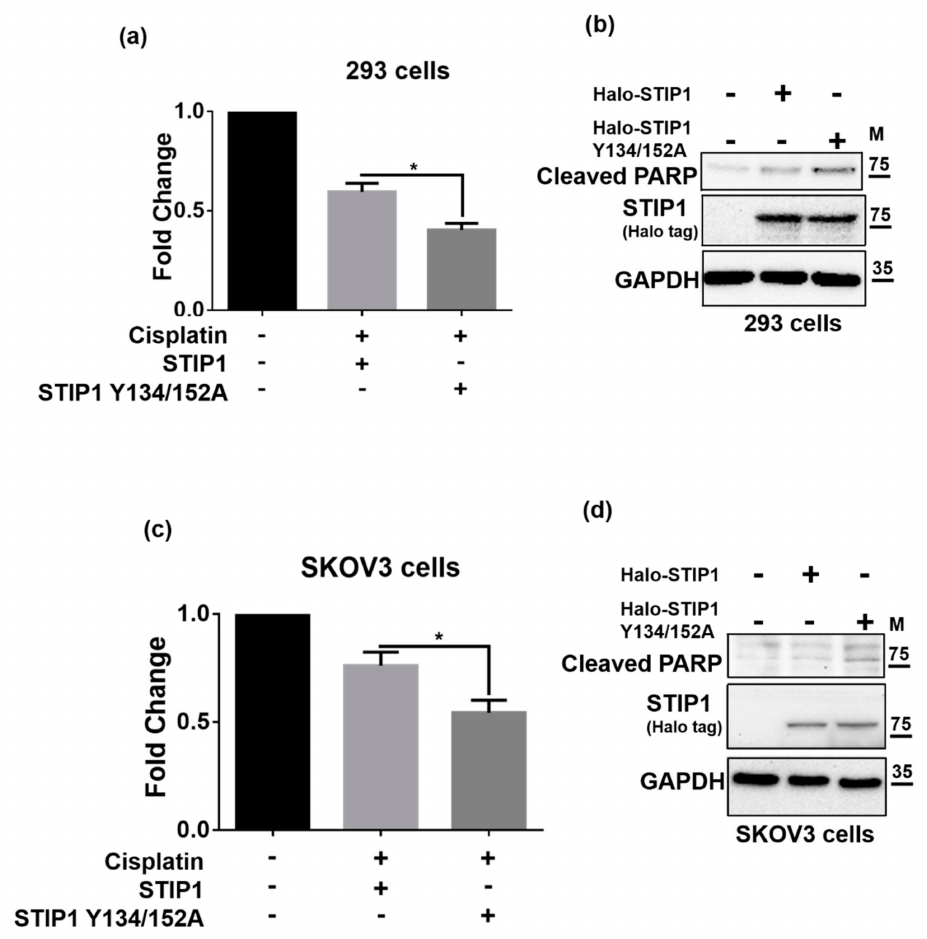
Figure 4. JAK2-mediated STIP1 phosphorylation inhibits cisplatin-induced cell death. ( a , b ) HEK293 cells and ( c , d ) SKOV3 cells were transfected with wild-type STIP1 or the STIP1 Y134/152A double mutant (Halo tag) for 24 h and subsequently treated with cisplatin (20 µ M) for additional 24 h. ( a , c ) Cell viability was determined using the CCK-8 assay according to the manufacturer’s protocol. ( b , d ) Protein levels of cleaved PARP, exogenous STIP1 (Halo tag), and GAPDH were assessed with western blot. Results are expressed as mean ± standard errors from three independent experiments; * p <